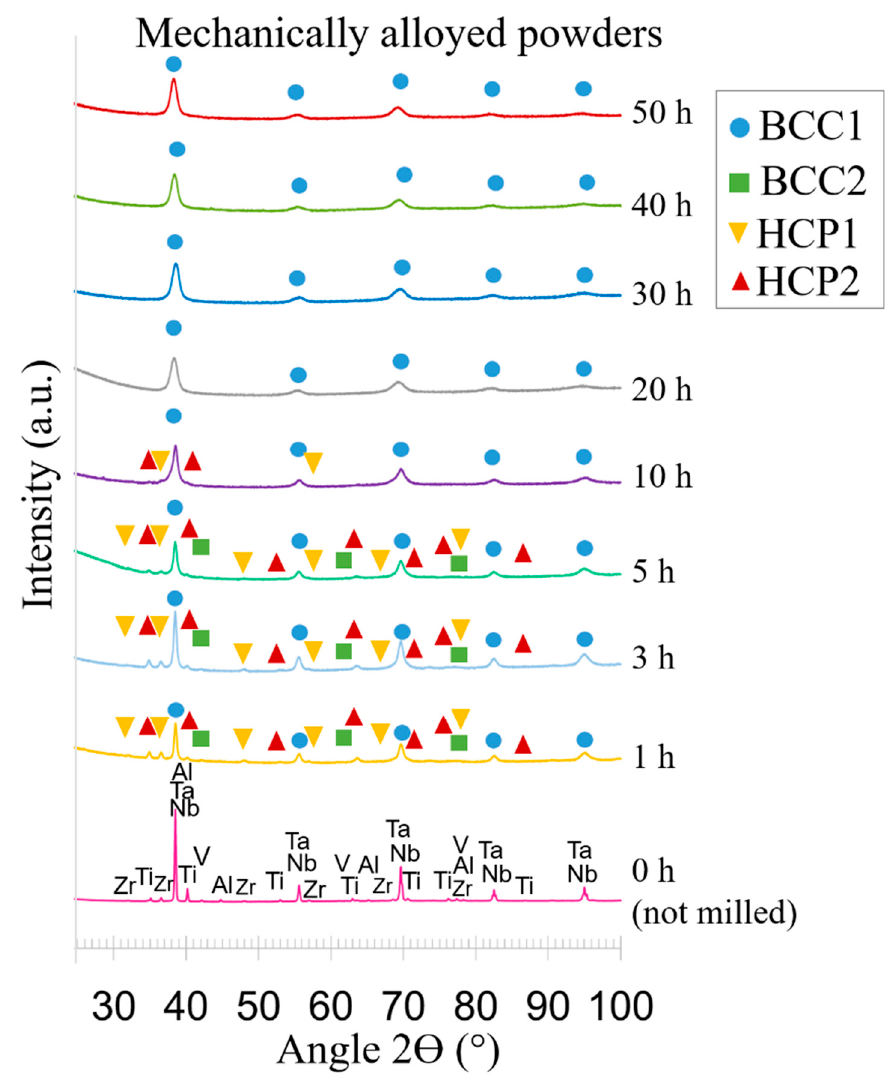
Table 1. Lattice parameters of the mechanically alloyed powders detected by XRD analysis. 1